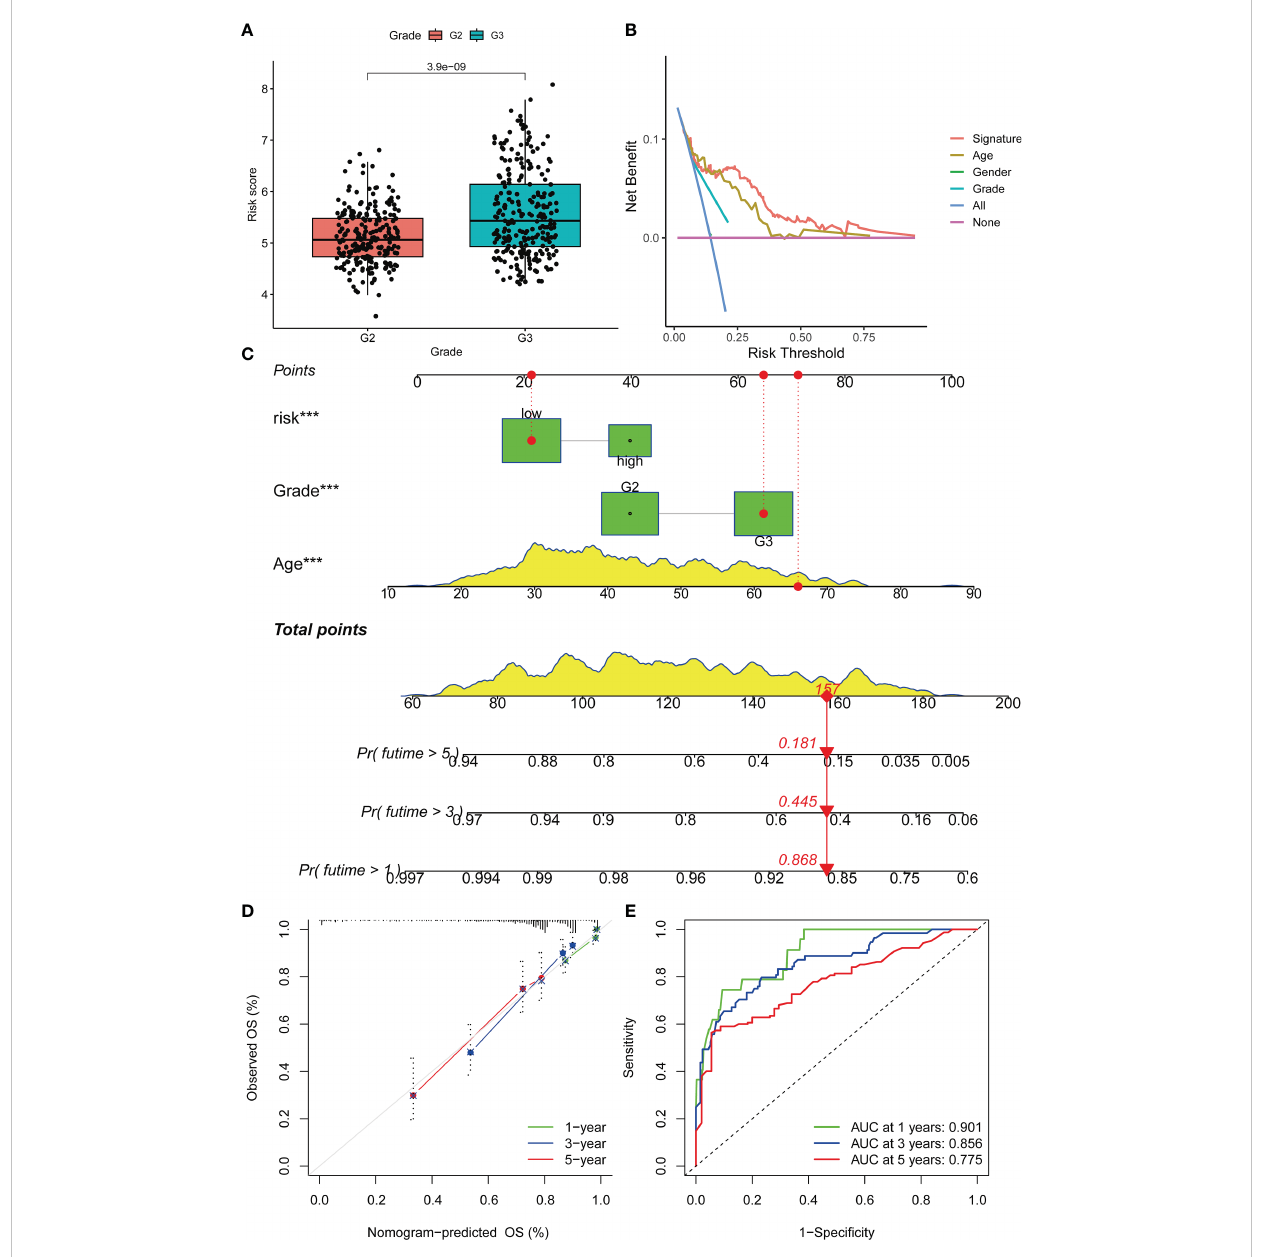
FIGURE 5 Prognostic prediction of glioma patients with other clinical factors based on the OS model. (A) Boxplots were used to display the difference in risk scores in different tumor grades. (B) Decision curve analysis of the constructed risk prediction model. Using the signature to predict patient survival can bene fi t the patient similar to other conventional clinical variables. (C) Nomogram integrating risk and clinical characteristics. (D) calibration of the nomogram at 1-year, 3- year and 5-year survival in the TCGA cohort. (E) Time-dependent ROC curve of the constructed nomogram model. Nomogram was built using the Multivariate proportional hazards model. Differential analyses were conducted using the Wilcoxon test. ***p <